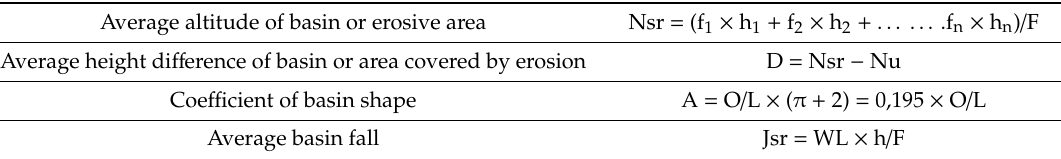
Table 1. Formulas for configuration terrain